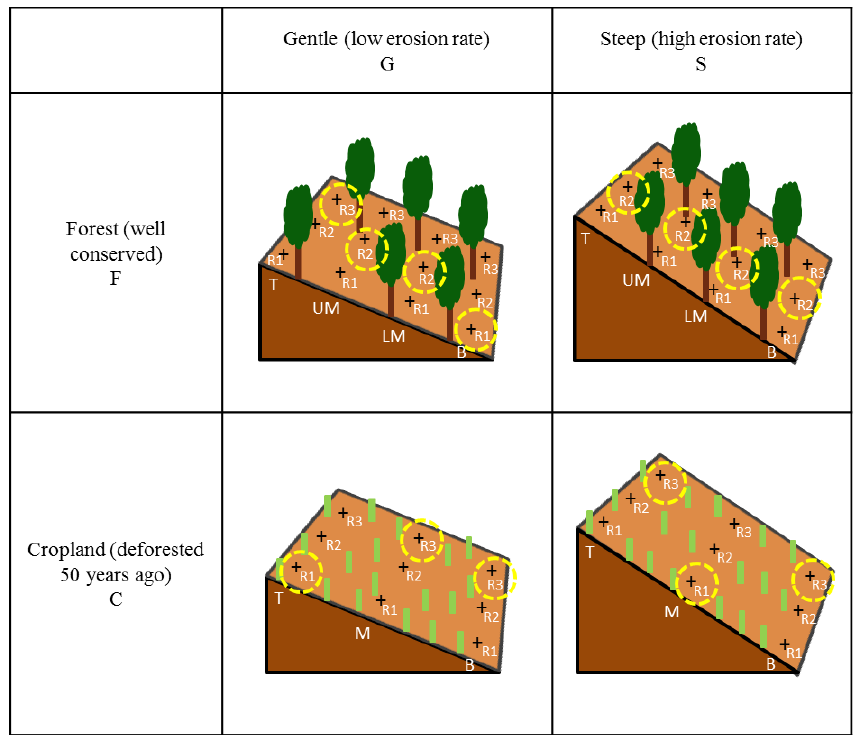
Figure 2. Diagram of the studied sites and the abbreviations used in the text ordered by ecosystem (F: forest; C: cropland), slope (G: gentle; S: steep), position (T: top; UM: upper middle; LM: lower middle; M: middle; B: bottom) and replicate (R1: replicate 1; R2: replicate 2; R3: replicate 3). Plus signs represent sampling points and yellow circles the selected